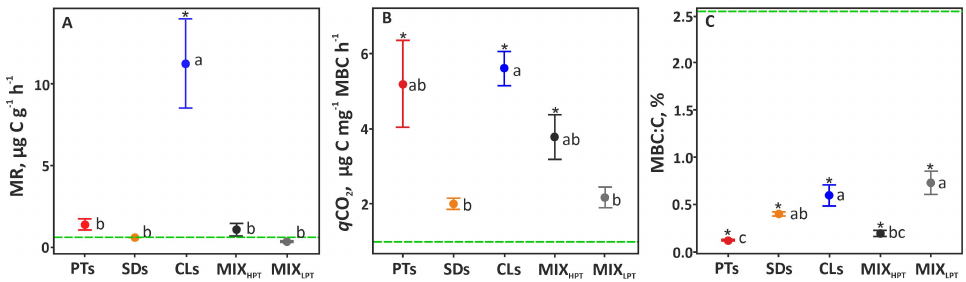
Figure 2. Microbial respiration (MR, A ), microbial metabolic quotient ( q CO 2 , B ) and ratio of microbial biomass carbon to total carbon (MBC:C, C ) in soil-like materials. Dotted green line represents the mean for the natural soil reference. Letters indicate the significantly different groups (Tukey’s test). Means with * indicate a significant difference from the natural soil (Dunnett’s